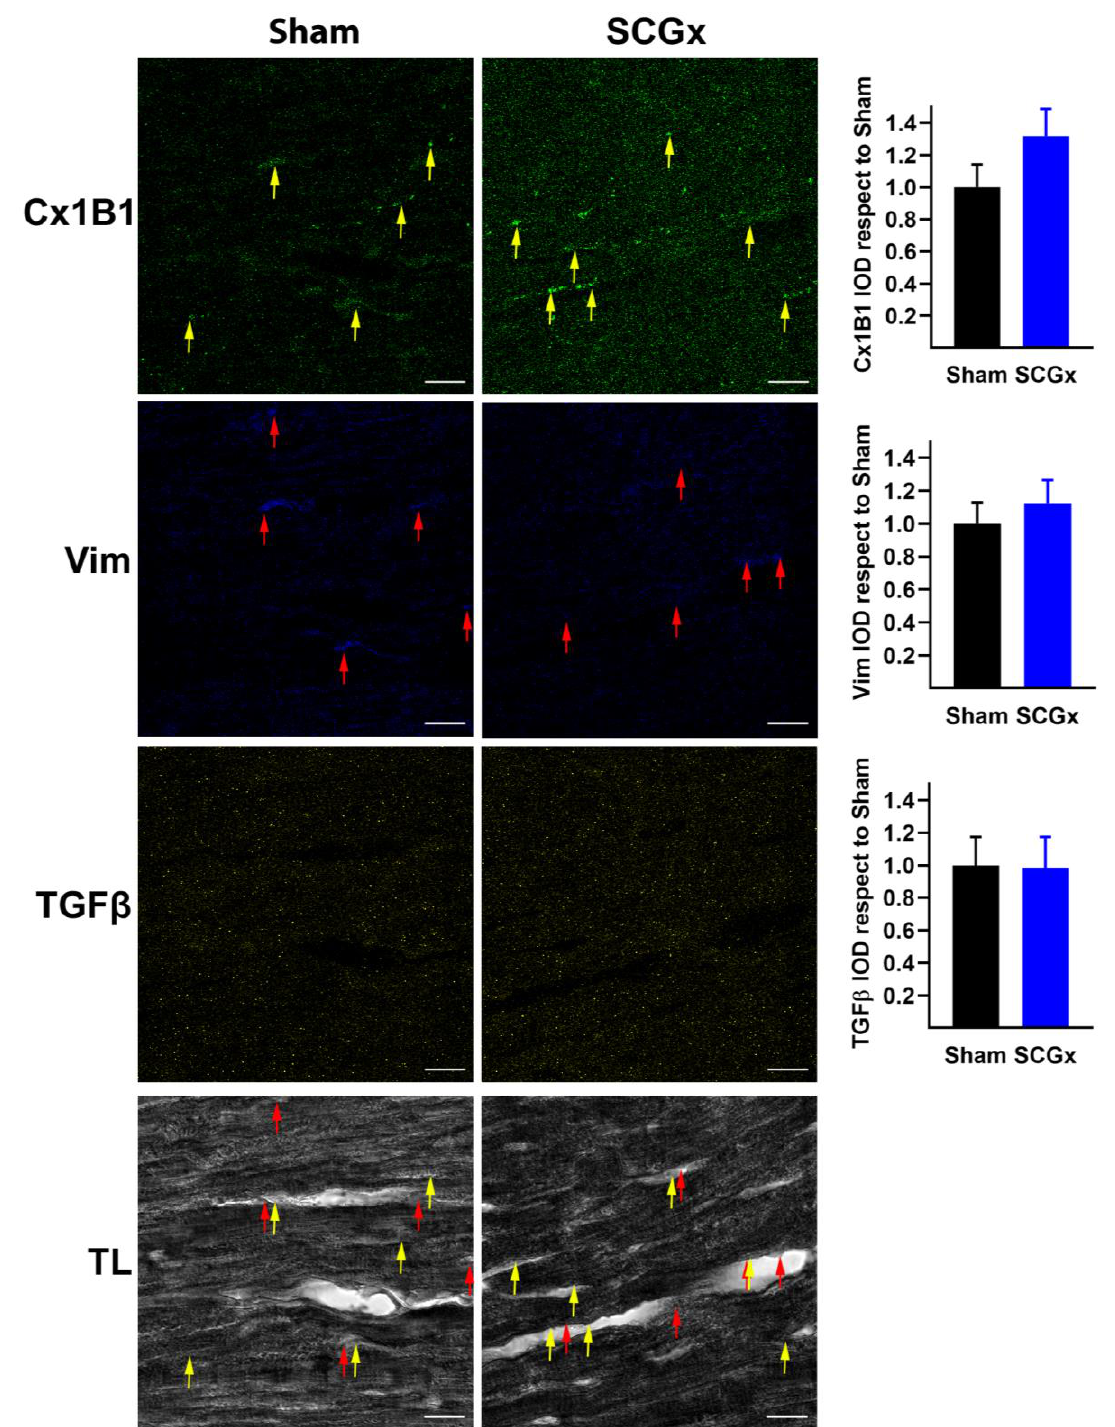
Figure 8. SCGx did not increase fibrosis. The unphosphorylated connexin 43 detected by the Cx1B1 antibody was lateralized mainly to the vascular side of the myocytes (yellow arrows), close to fibroblast marker vimentin (Vim, red arrows). Sham and SCGx groups showed the same levels of Vim and the profibrotic stimulus TGFβ (yellow staining). Bars indicate the mean integrated optical density (IOD) and SEM values relative to the level measured in the Sham group. The white scale bars in the lower right corners indicate 20 µM. In both groups, a total of 18 pictures were analyzed, six from three different hearts.